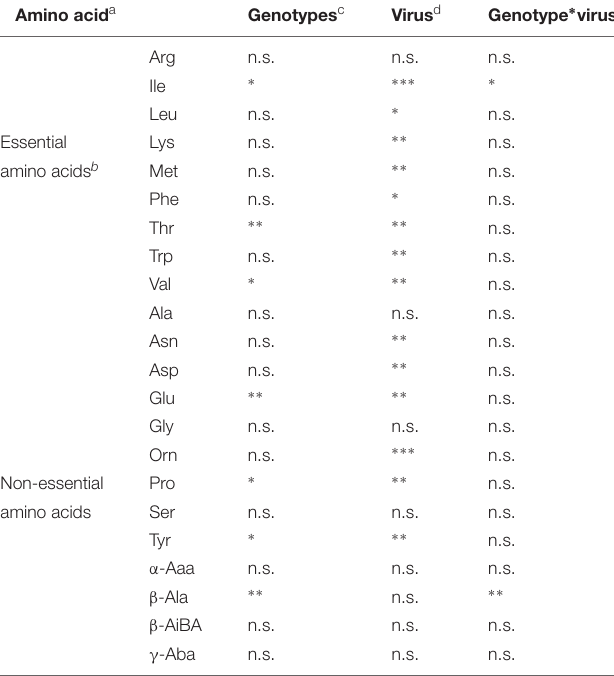
TABLE 2 | ANOVA results for the effects of B. tabaci genotypes and virus (TYLCV) on the mol% of free amino acids in the honeydew of B. tabaci adults. Amino acid